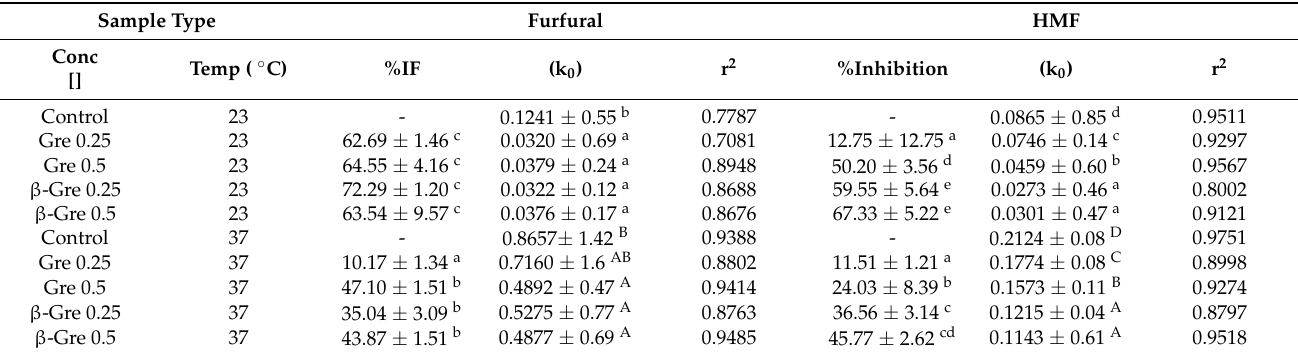
Table 2. Inhibitory capacity of green rooibos extracts against the formation of furfural and HMF in canned apples during